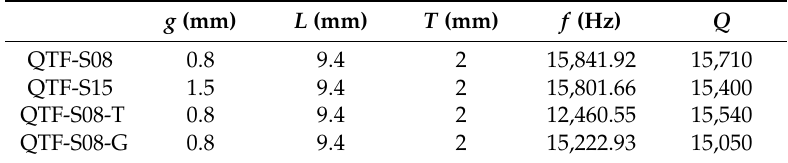
Table 2. Parameters of the second generation of the custom QTFs: Prong spacing ( g ), prong length ( L ), prong thickness ( T ), frequency ( f ) and quality factor ( Q ) in atmospheric pressure. g